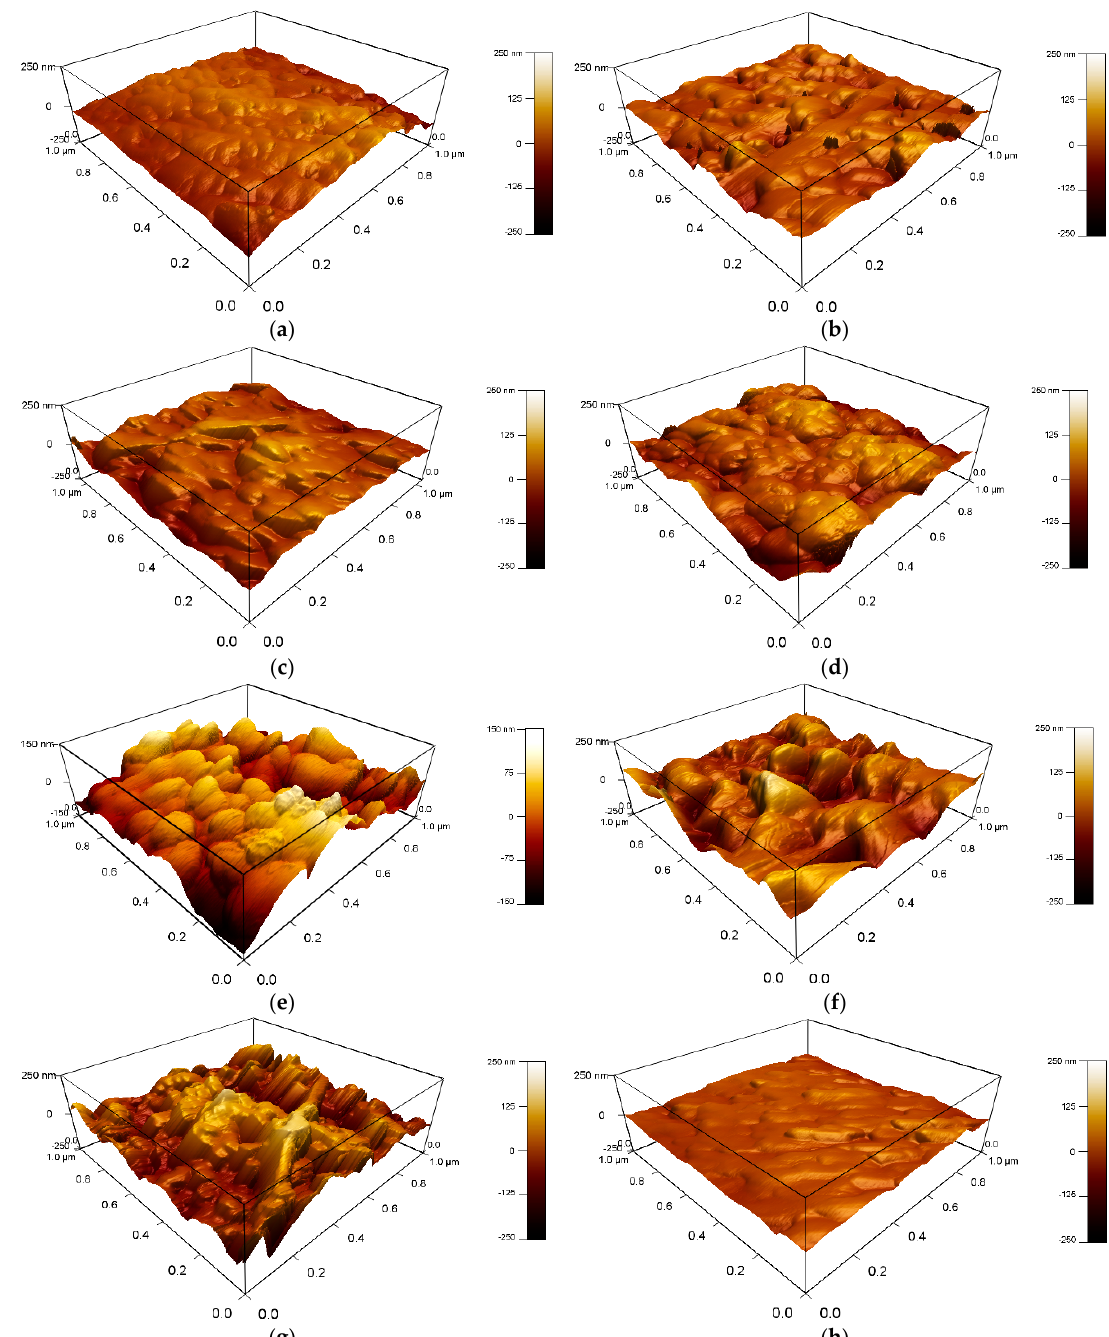
Figure 6. AFM 3D images for ( a ) PS1, ( b ) PS2, ( c ) PS3, ( d ) PS4, ( e ) PA1, ( f ) PA2, ( g ) PA3, and ( h ) PA4.